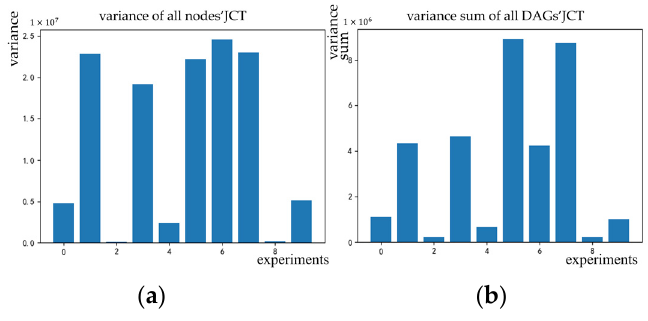
Figure 8. The variance in JCT in scientific workflows.